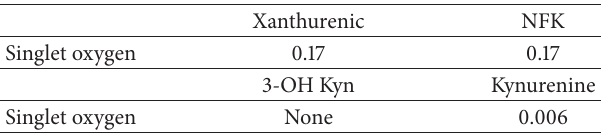
Table 1: Quantum yields for singlet oxygen for lenticular chro- mophores.